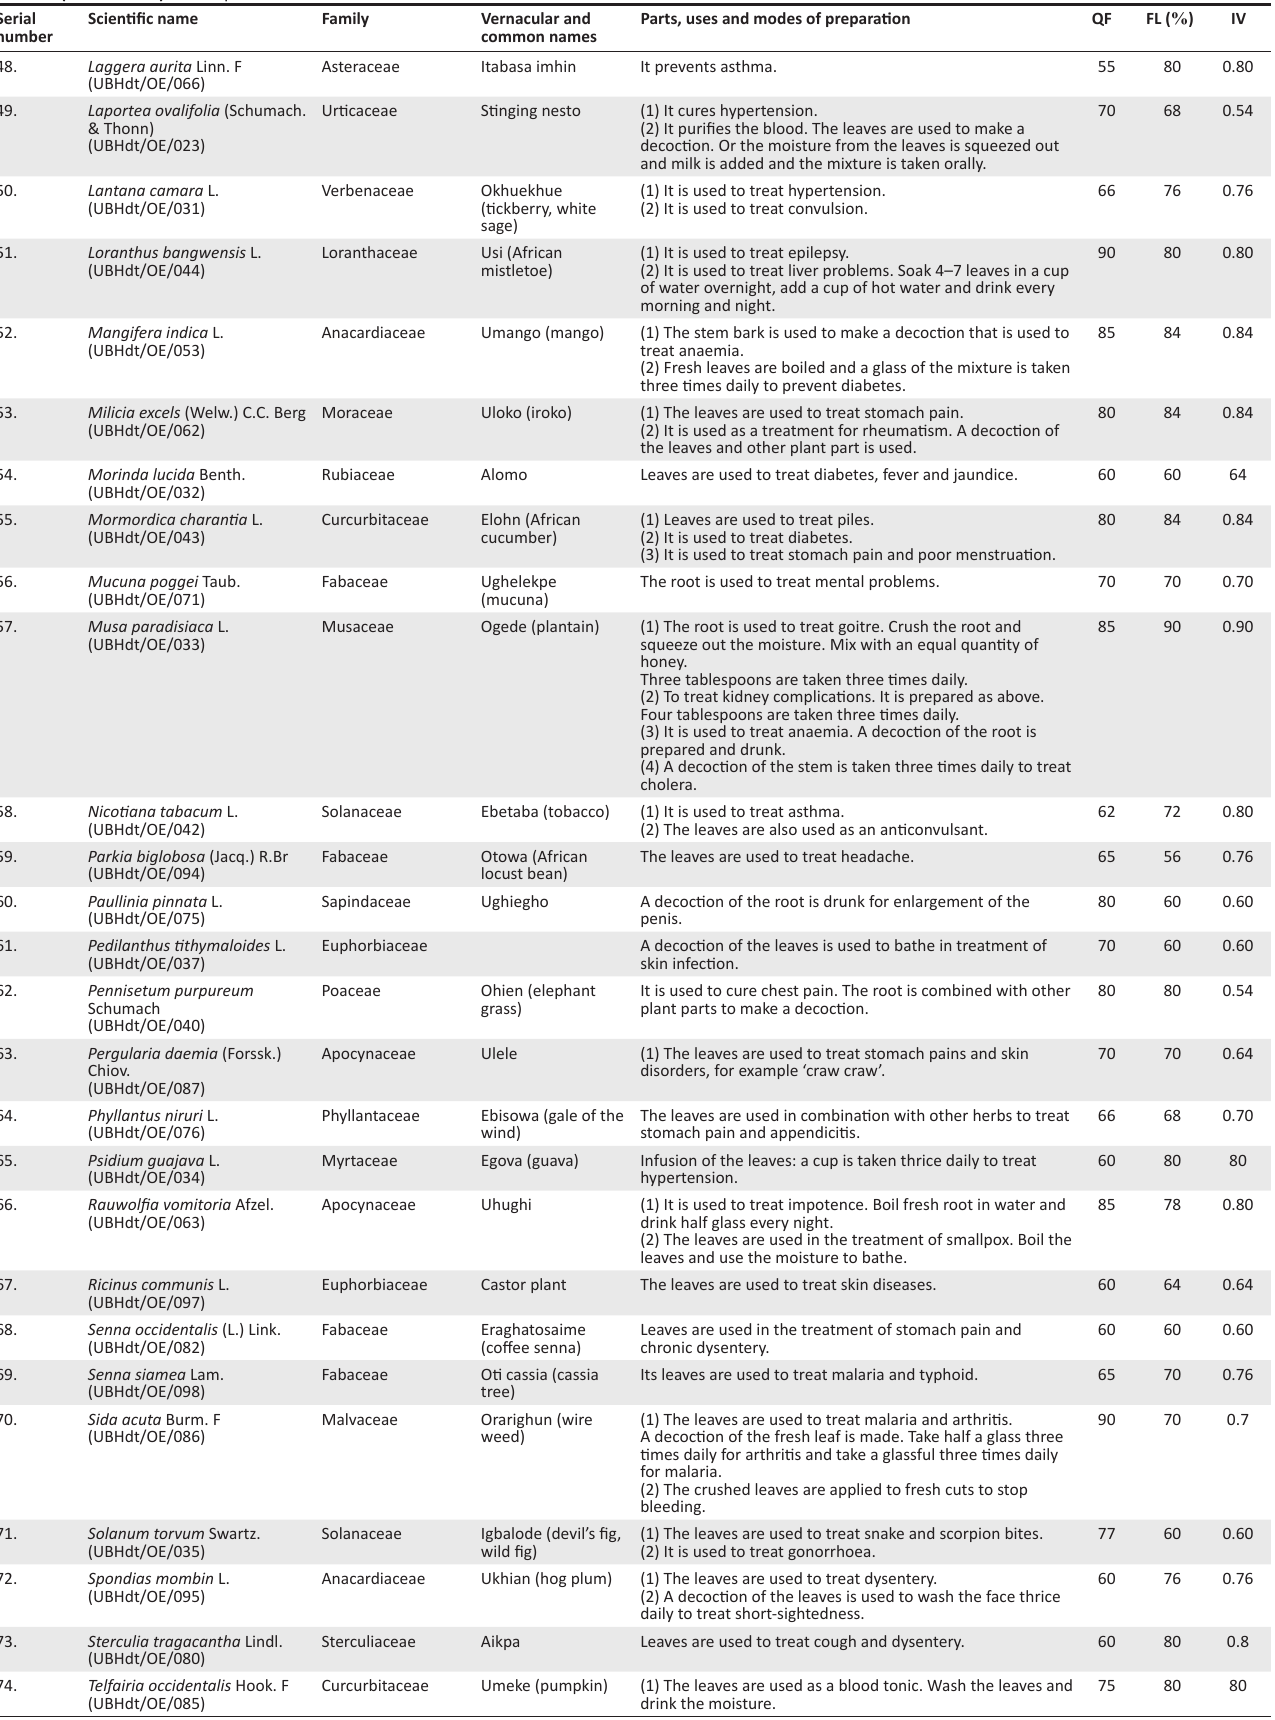
Table 1 continues on the next page